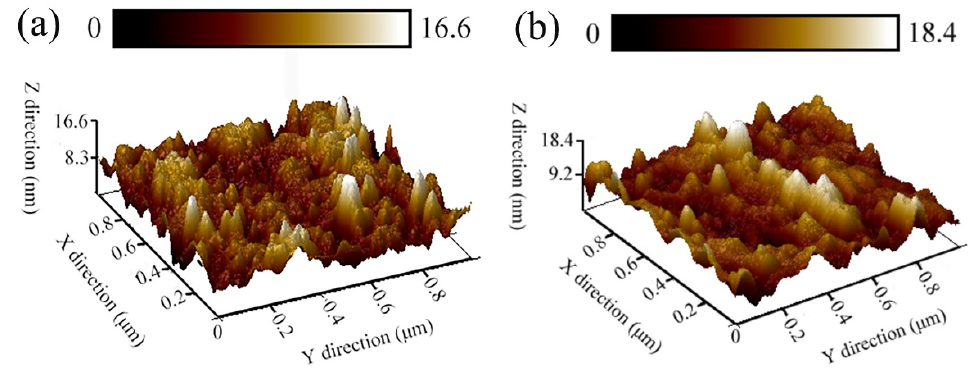
Figure 3. ( a , b ) are are high-magnification detailed micrographs of pre-tested surfaces for as-cast and treated samples to be tested under AFM.